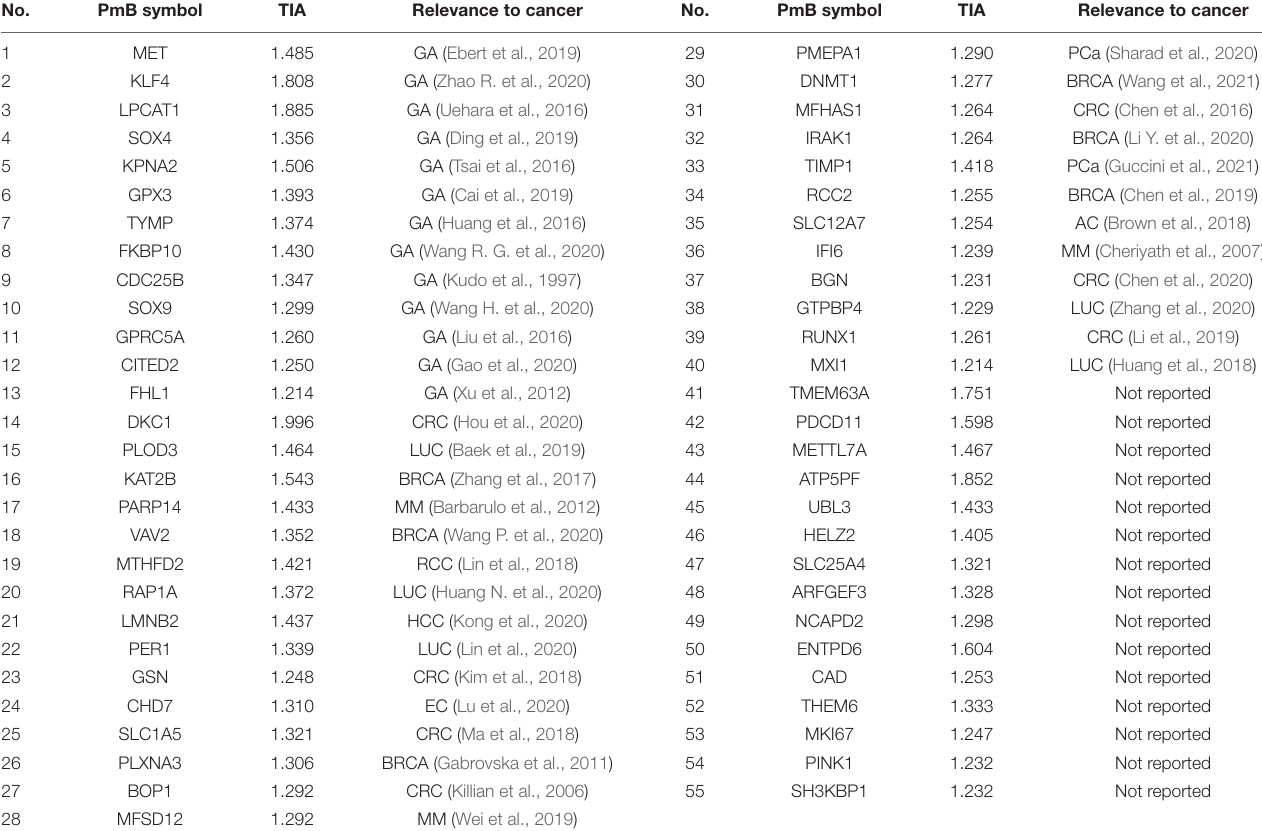
TABLE 2 | The identified PmBs and their total information